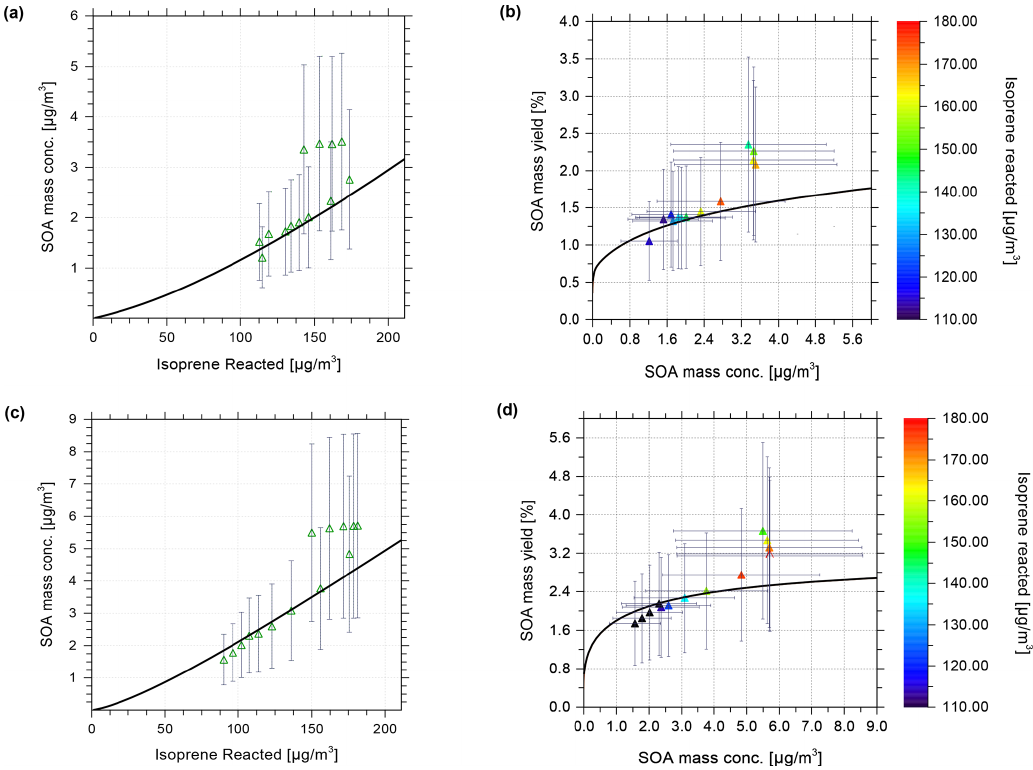
Figure 3. Comparison of CLOUD chamber measurements and model calculations of SOA formed for varying levels of isoprene reacted. Experimental conditions are + 5 ◦ C at 35% RH and 85% RH, without seed particles present in the continuous flow chamber. Model calcula- tions shown as black curves were performed at the same temperature and RH as the experiments. Model–measurement comparison of SOA mass concentration vs. isoprene reacted at (a) 35% and (c) 85% RH. Hollow green triangles show the measured data at MCM-determined levels of isoprene reacted [ISOPRCT] in the chamber (Fuchs, 2017), with error bars indicating 50% measurement uncertainty for SOA mass concentration. A comparison of SOA mass yield vs. SOA mass concentration for (b) 35% and (d) 85% RH is shown. Solid triangles show the experimental data, which are coloured based on the level of isoprene